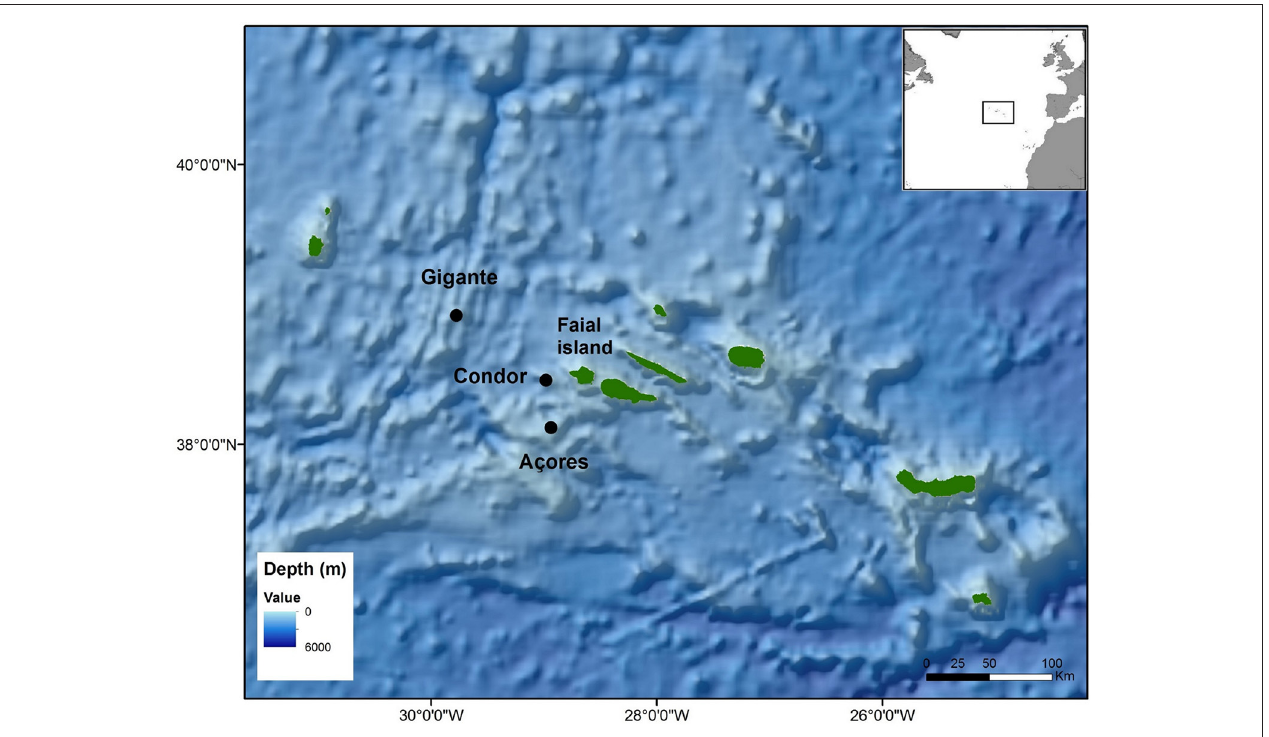
FIGURE 1 | Ecological Acoustic Recorders (EARs) deployment locations in the Azores archipelago (black dots).